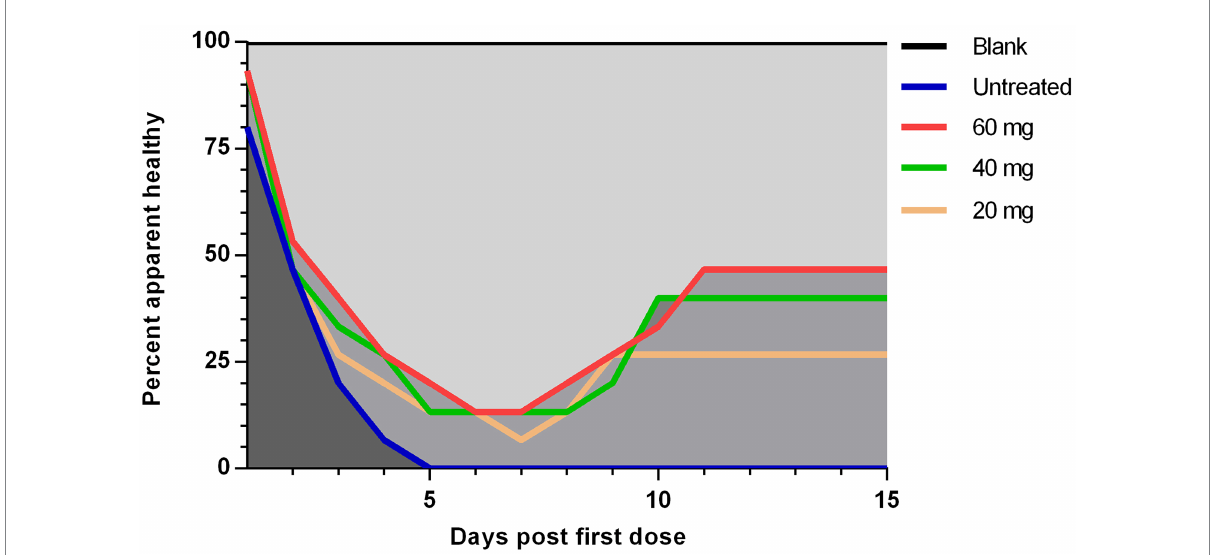
FIGURE 3 The apparent curative rate of experimentally NDV infected chickens during and after treatment with 20, 40, and 60 mg/k.g BW n -docosanol. The number of chickens without ND clinical signs in each group was recorded at 1–15 days post the first n -docosanol dosage injection. The apparent curative rate was calculated by the formula: Apparent curative rate = the number of chickens without ND clinical signs / the total number of chickens per group. One-way ANOVA with Tukey’s multiple range test was used to compare between the groups. A significant difference ( value of p of <0.05) appeared between the untreated group and both the high (60 mg/kg) and medium (40 mg/kg) dosage